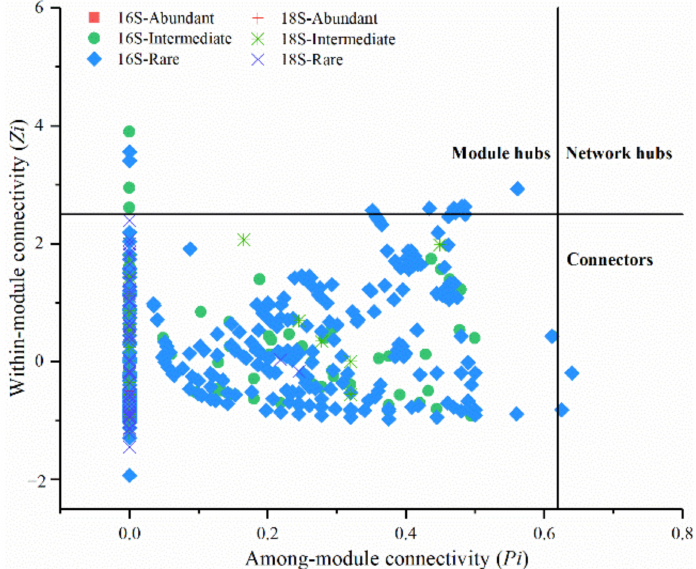
Figure 6. Classification of nodes to identify putative keystone species within the 16S and 18S networks. Each symbol represents an OTU. Module hubs have Zi ≥ 2.5, whereas connectors have Pi >